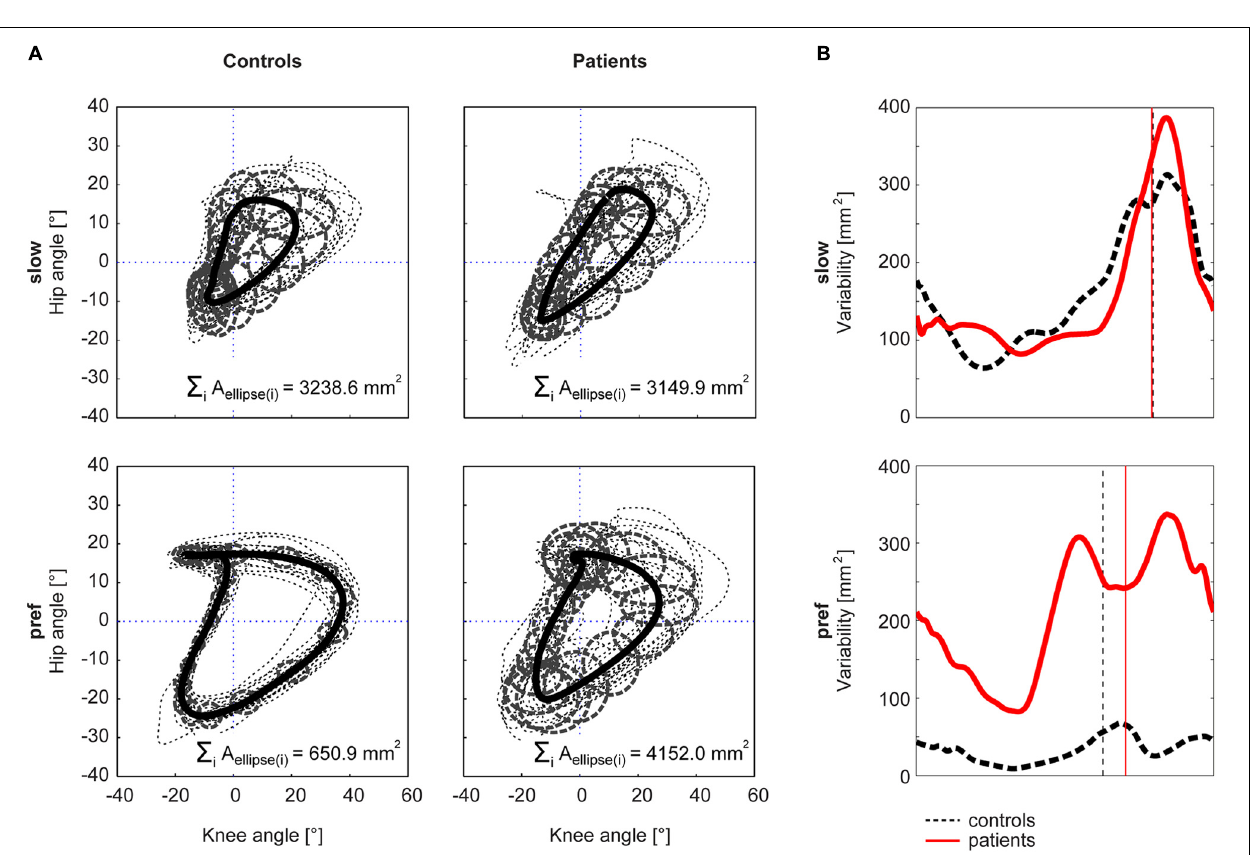
FIGURE 2 | (A) The cycle-to-cycle shape consistency within a subject is quantified as the angular component of coefficient of correspondence (ACC). This value can attain values between 0 (no congruency between cycles) and 1 (complete shape congruency from cycle to cycle). Both groups increased their cyclogram consistency when changing from a slow to preferred walking speed. iSCI subjects only showed lower